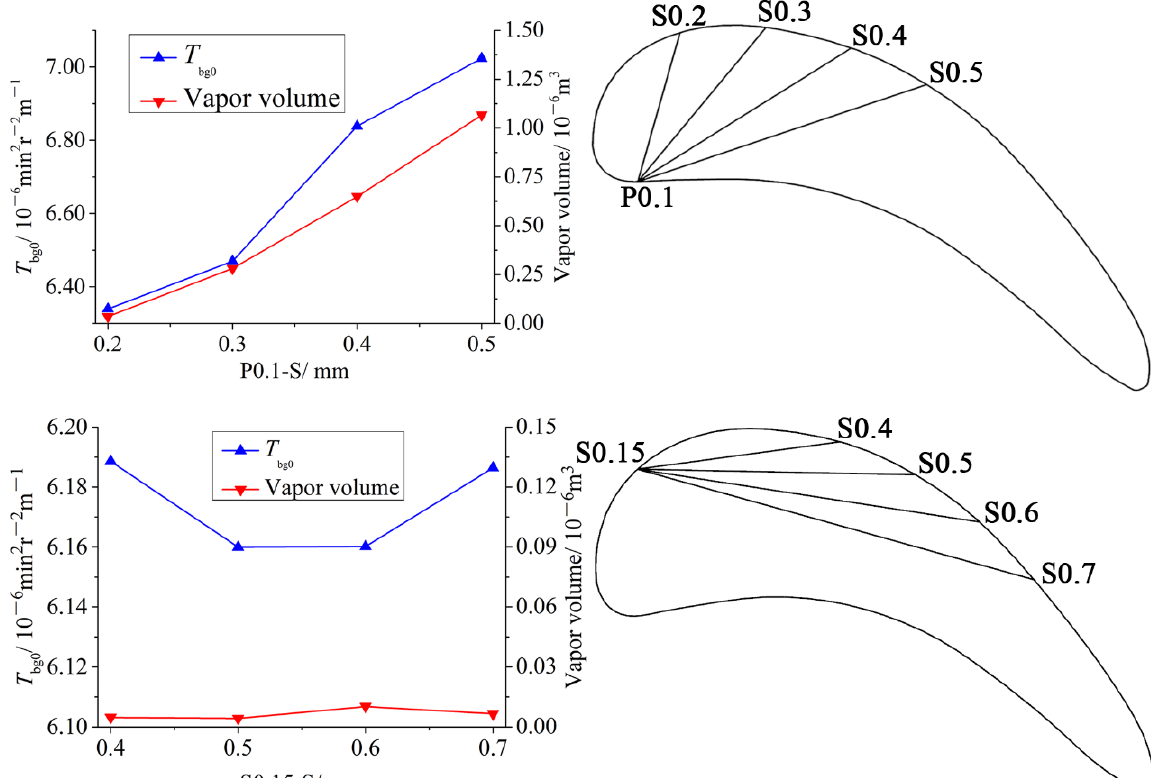
Figure 15. Effect of slot position on T bg0 and stator vapor volume (slot width = 2 mm).